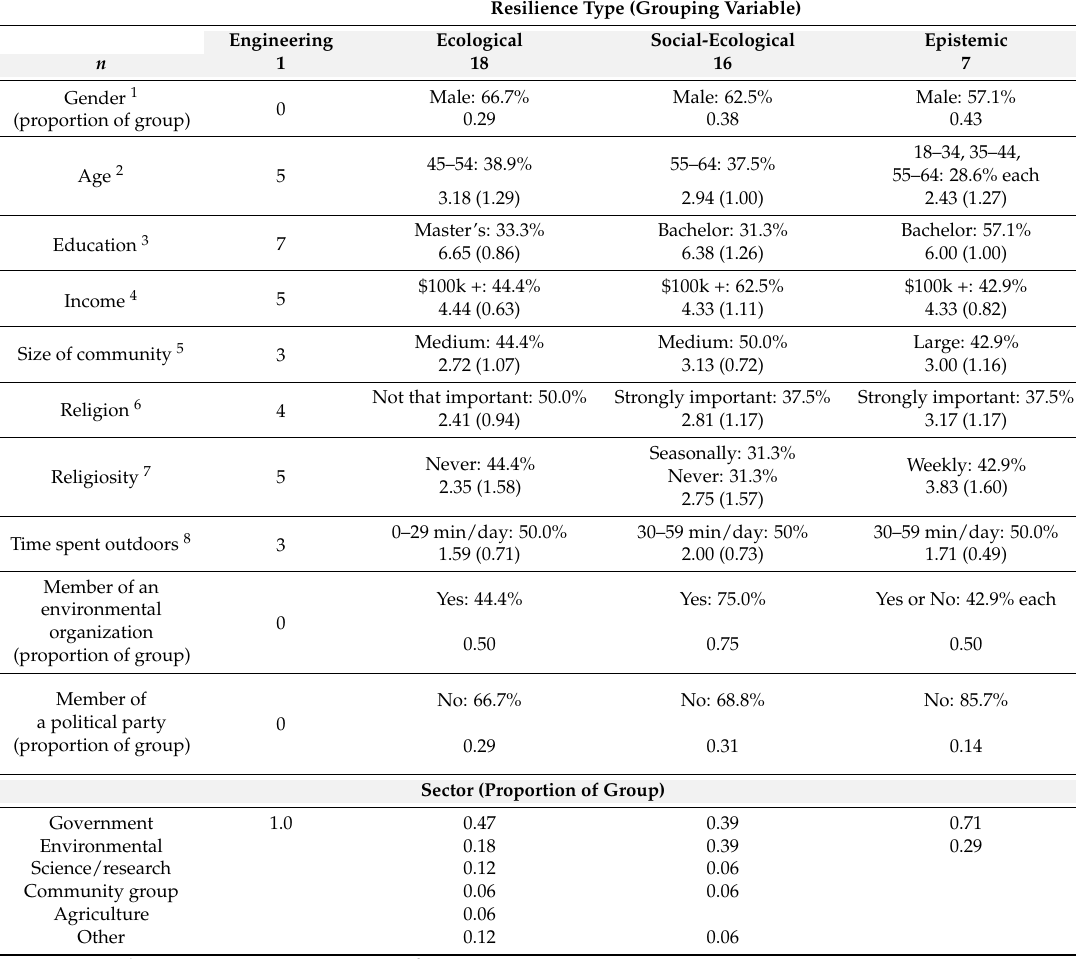
Table 1. Demographic data for respondents grouped by resilience type. Most common response (mode) and percentage of responders choosing the option are presented first, followed by means and standard deviations presented unless otherwise